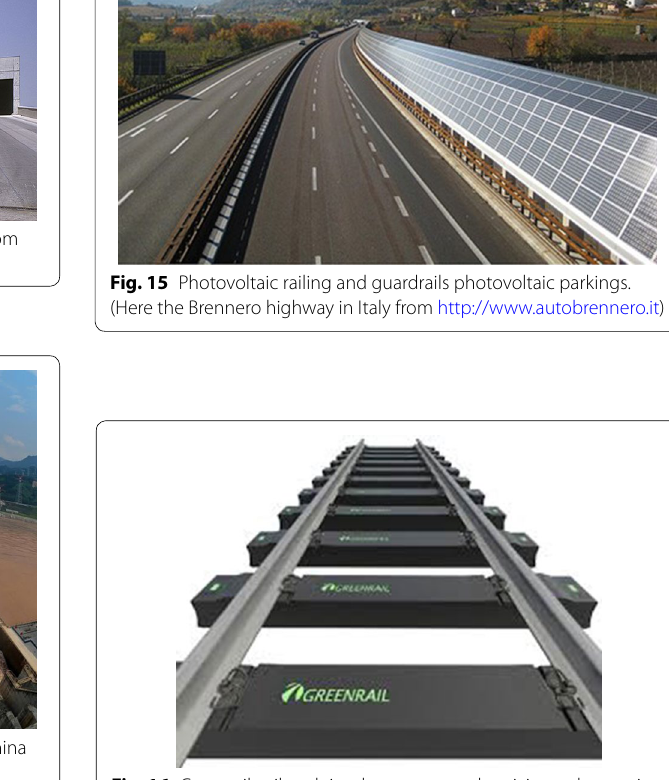
Fig. 16 Greenrail: railroad ties that generate electricity to the passing of trains (from http://www.green rail.it)